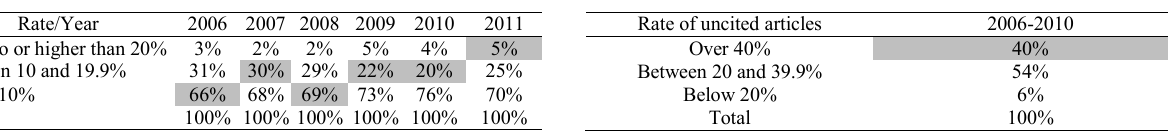
Table 6. Percentage of zoology journals in Sample 1 according to uncited article rate intervals.